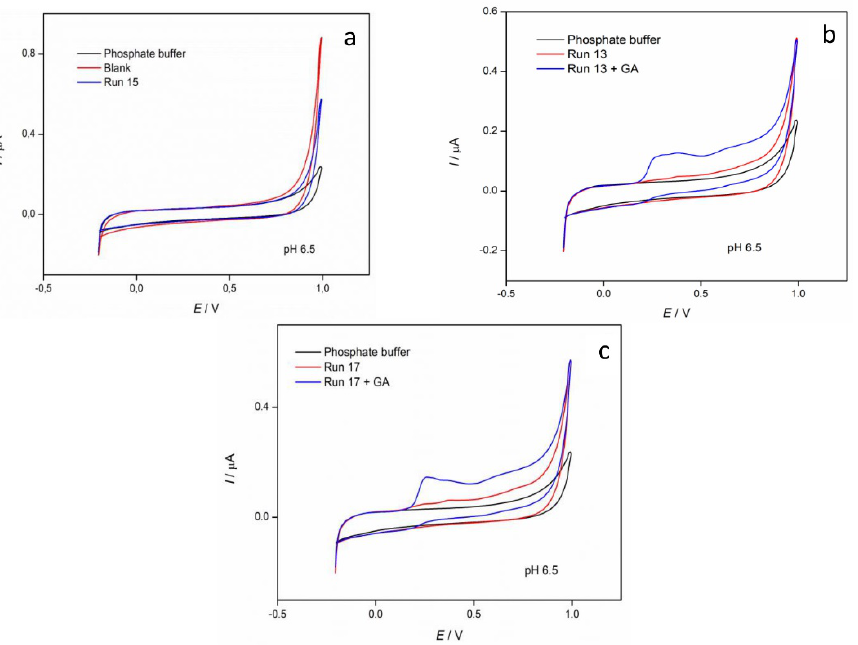
Figure 9. Cyclic voltammograms of phosphate buffer pH = 6.5 (—) and ( a ) calcium oxalate precipitate (Blank (—) and Run 15 (—), ( b ) Run 13 (—) and Run 13 with added gallic acid (GA) (c = 0.02 mM) (—), ( c ) Run 17 (—) and Run 17 with added gallic acid (GA) ( c = 0.02 mM) (—). Scan rate 100 mV/s.